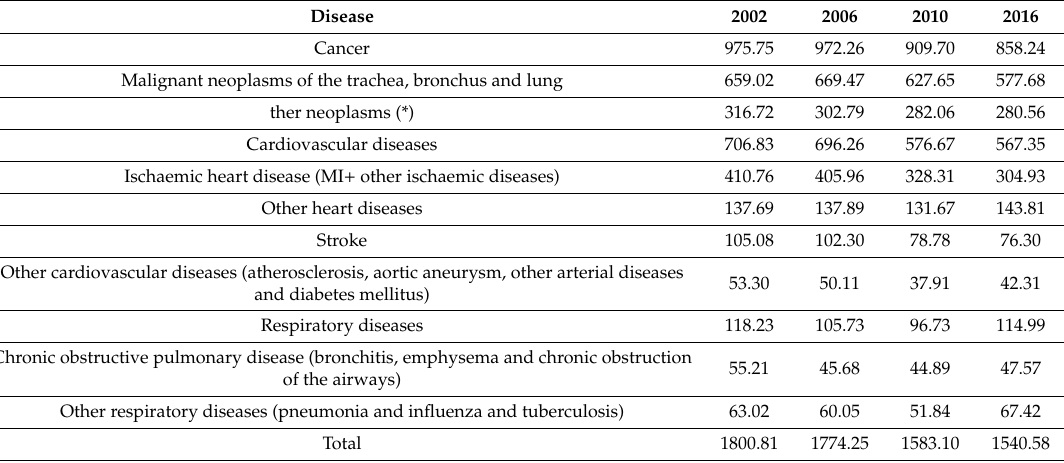
Table A3. Labour losses (base case) (millions of euros).